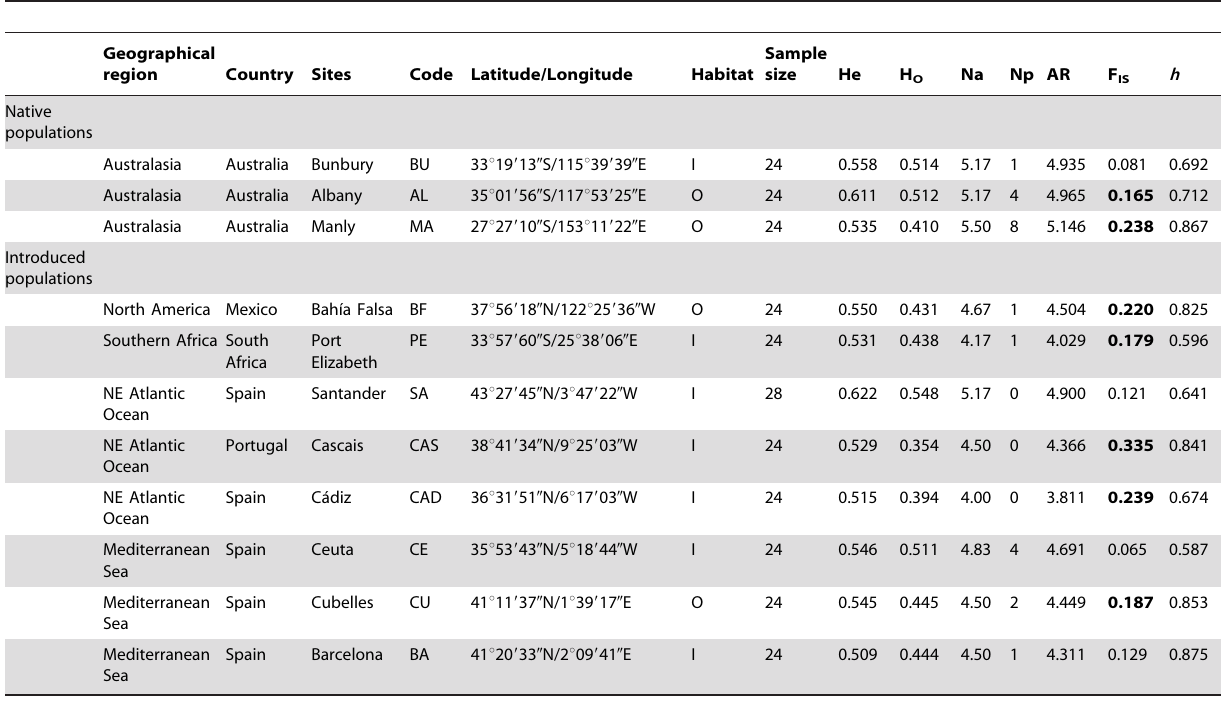
Table 1. Collection sites of Microcosmus squamiger including geographical regions, population abbreviations (Code), type of habitat (O: outside harbour, I: inside harbour) and number of individuals